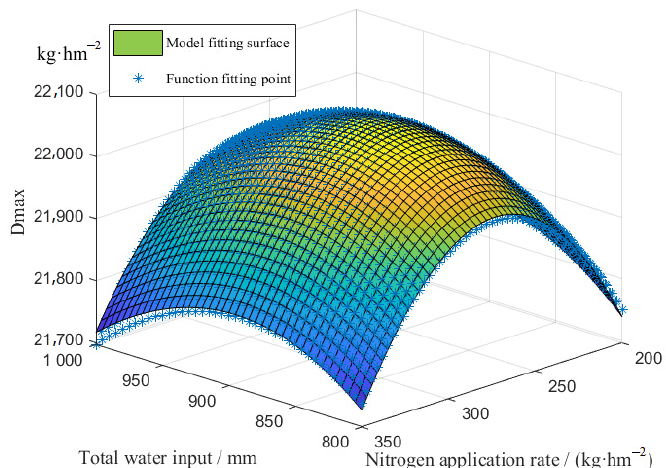
Figure 7. Fitting results for D max with the quadratic polynomial based on the values predicted by the Gaussian regression model.